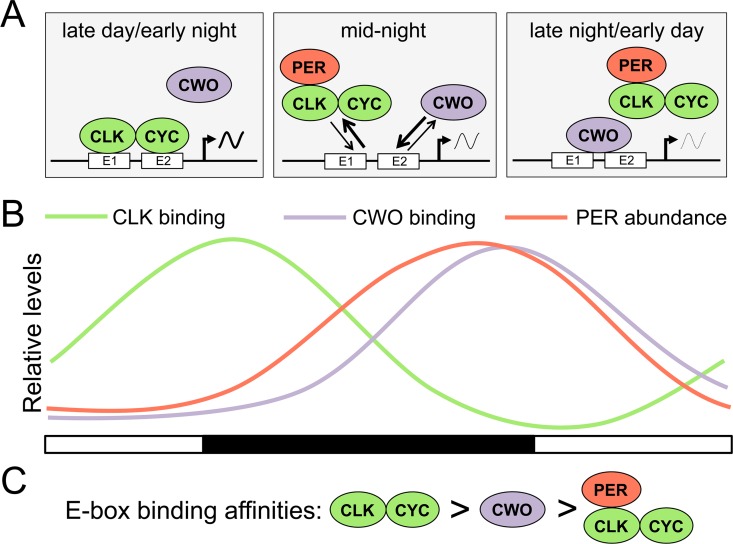
Model for PER dependent binding competition between CWO and CLK-CYC on E-boxes.(A) Diagrams depicting clock protein interactions and E-box binding at different times of day (gray rectangles). During late day/early night, CLK-CYC (green ovals) initiate the transcription cycle by binding to E-boxes (white rectangle) in the presence of CWO (purple oval), which is unable to bind E-boxes. During mid-night, PER (red oval) enters the nucleus and interacts with CLK-CYC, producing PER-CLK-CYC complexes that allow CWO binding to E-boxes. During late night/early day, the high PER levels insure efficient PER-CLK-CYC complex formation, thus allowing strong CWO binding to E-boxes. (B) Graph showing the relative levels of CLK-CYC binding (green line), CWO binding (purple line) and PER abundance (red line) during a light (white rectangles) and dark (black rectangles) cycles. (C) Proposed E-box binding affinities, where CLK-CYC binding is greater than (>) CWO, and CWO binding is greater than PER-CLK-CYC.